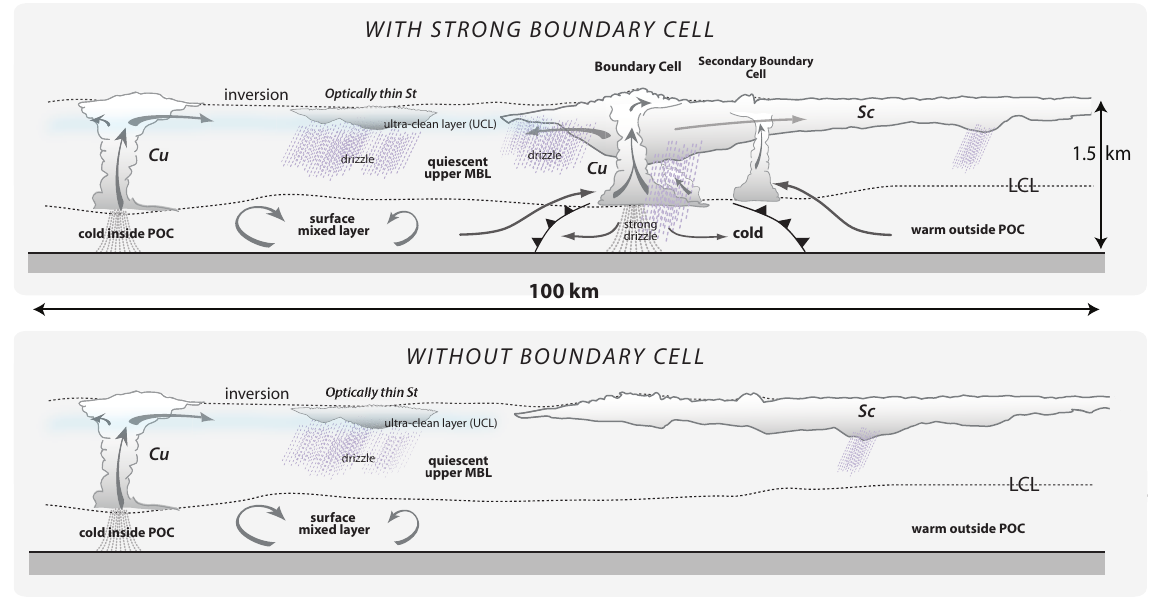
Fig. 21. Conceptual diagram of the POC-transition-overcast MBL as observed during RF06. Two realizations are shown: one in which a strong boundary cell is present, and one where no clear boundary cell is evident.